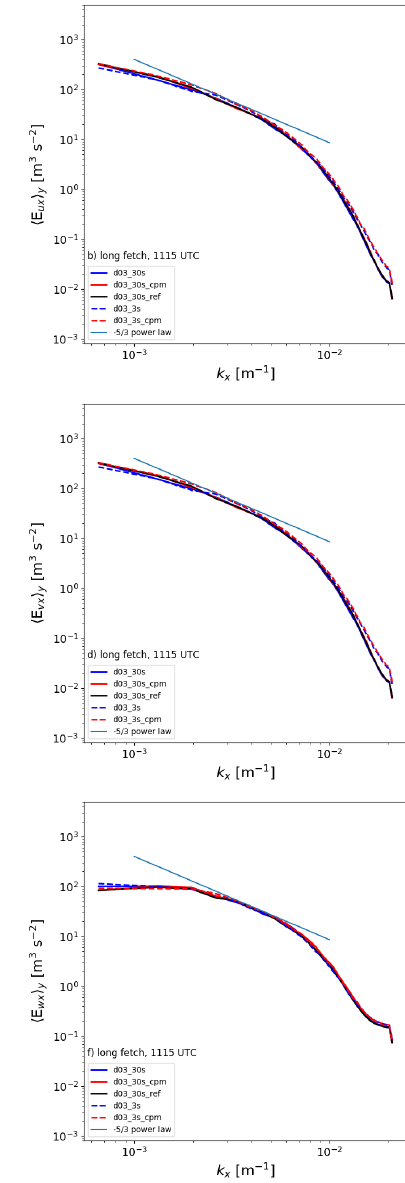
Figure 14. As in Figure 13b,c but for simulations with 3 arcsec topography input.